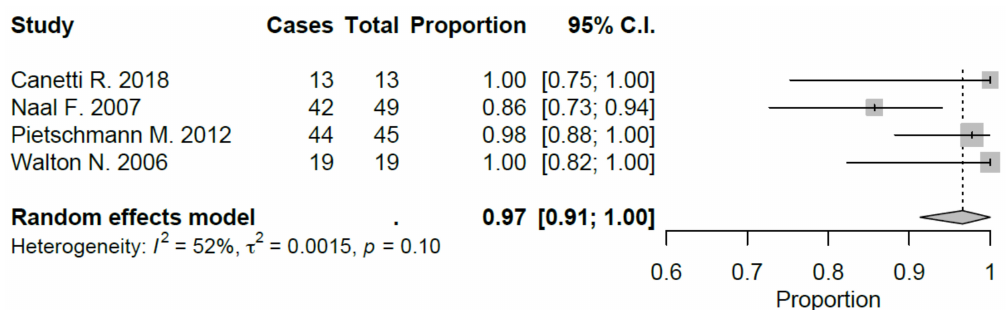
Figure 3. Return to hiking after UKA (C.I.: Confidence Intervals).